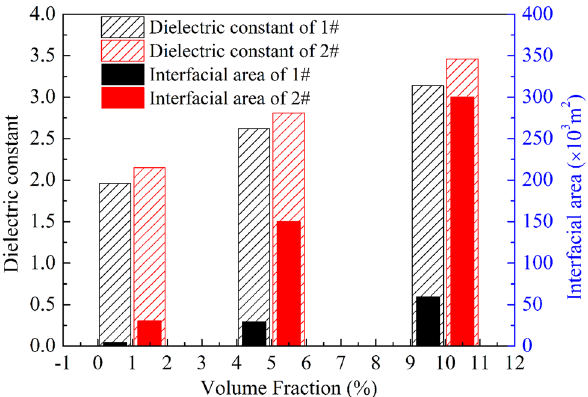
Figure 5: Comparison diagram of dielectric constant and interfacial area of the CCTO/LDPE and CCTZO/LDPE composites with di ff erent